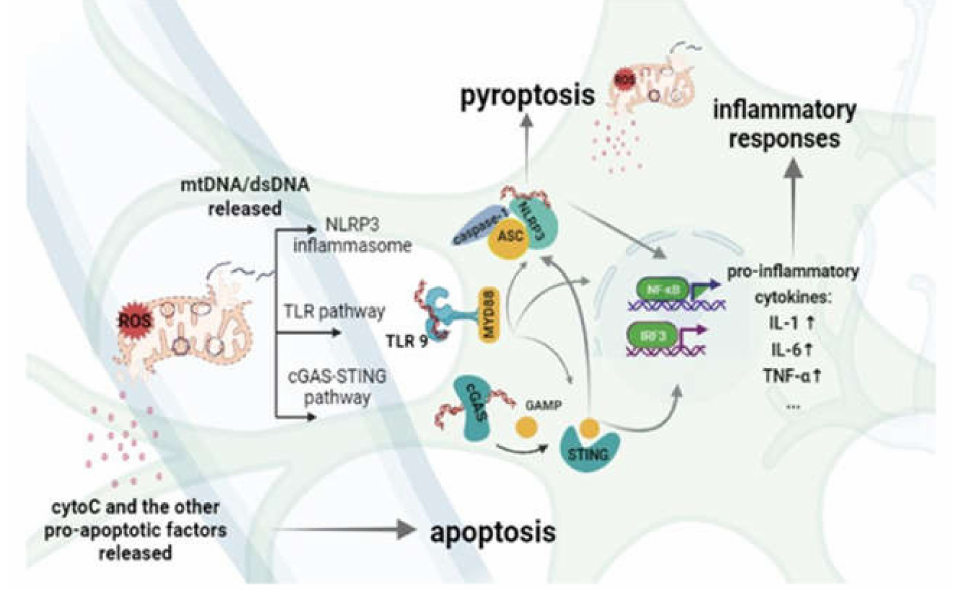
Figure 2. The main inflammatory response is mediated by mtDNA/dsDNA in IR/I. When mito- chondria are damaged by oxidative stress, the permeability of the mitochondrial membrane will increase, and the leakage of cytochrome c and other apoptosis-inducing molecules in the mitochon- drial matrix will initiate the apoptosis pathway. Then, the released mtDNA/dsDNA causes a series of inflammatory reactions: NLRP3 recruits caspase-1 (caspase-1) to form inflammasomes through the caspase recruitment domain (ASC), and it induces cell burns. On the one hand, it responds to the pro-inflammatory signal of TLR; TLR can directly recognize mtDNA/dsDNA through the MYD88 pathway, cGAS recognizes mtDNA in the cytoplasm, produces cGAMP, promotes the dimerization and activation of STING, and STING can also promote the outflow of K+ ions to participate in the NLRP3 pathway. The resulting inflammatory signal can also further activate the TLR located in the endosome, so that inflammation can be magnified. Finally, the NF κ B and IRF3 pathways induce the production of inflammatory signals, leading to the massive release of cytokines IL-1, IL-6, TNF- α , etc., and triggering an inflammatory